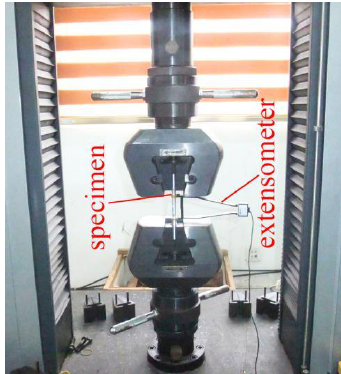
Figure 2. Loading device.